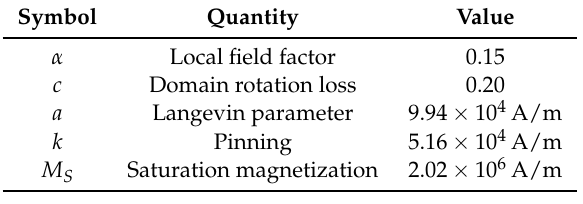
Table 6. Parameters of the Jiles–Atherton model for the FeCrCo 48/5 SHMM.